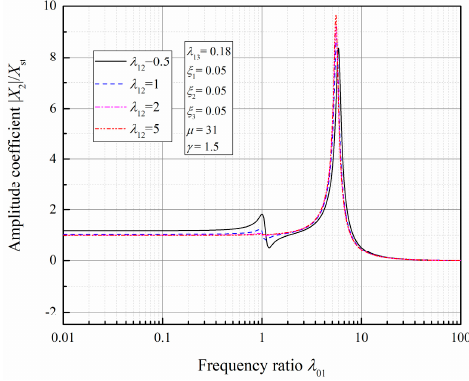
( ) . 0 2 5 λ λ < ≤ 12 12